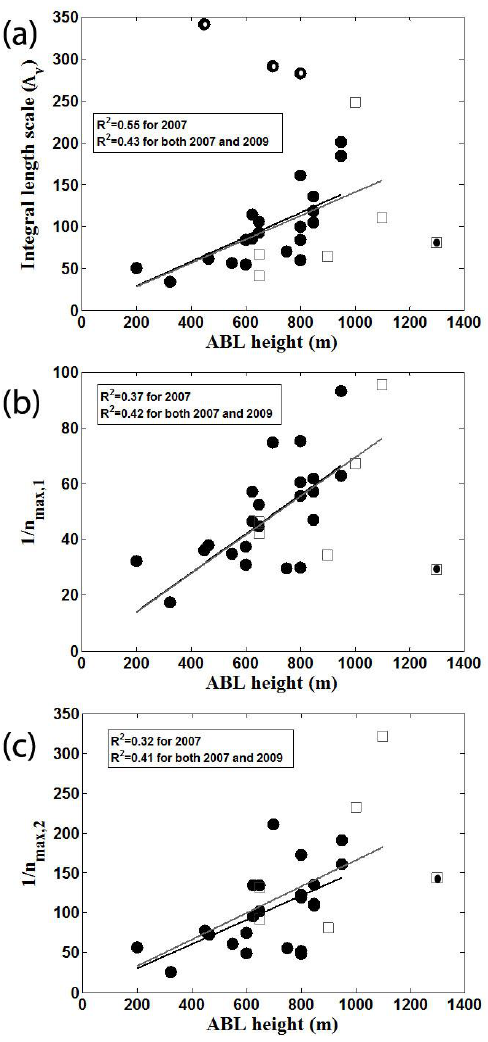
Figure 6. The comparison of observed ABL height to (a) integral length scale (  ), (b) 1/n max,1 and Fig. 6. The comparison of observed ABL height to (a) integral length scale ( 3 ), (b) 1 /n max , 1 and (c) 1 /n max , 2 for the cross- (c) 1/n max,2 for the cross-stream component ( v ) of the wind, where n max,1 and n max,2 are normalized stream component ( v) of the wind, where n max , 1 and n max , 2 are normalized spectral peak frequency obtained from Eqs. (3) and (4), spectral peak frequency obtained from Eq. (3) and (4), respectively. Black circles represent data respectively. Black circles represent data for BEARPEX 2007 and for BEARPEX 2007 and gray squares for 2009. Black lines denote the linear fit only for 2007 gray squares for 2009. Black lines denote the linear fit only for 2007 data and gray lines for the whole data points except those marked by data and gray lines for the whole data points except those marked by black and white dots. black and white dots. Detailed results are also presented in Table Detailed results are also presented in table 2.